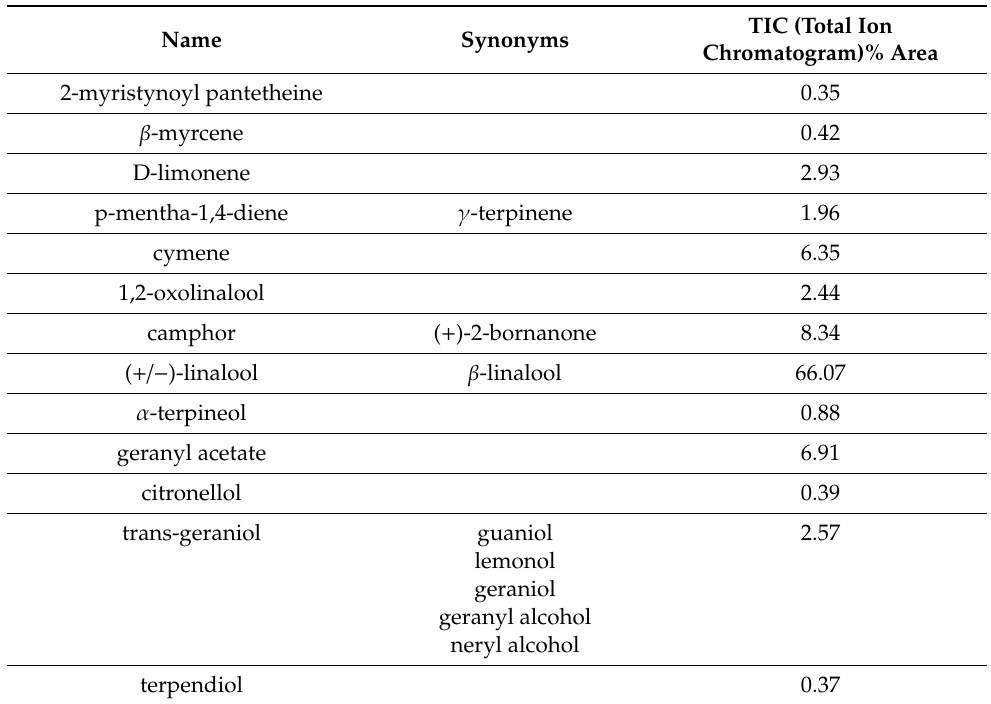
Table 1. Relative chemical composition of coriander essential oil (CEO) obtained by GC-MS (gas chromatography coupled with mass spectrometry)